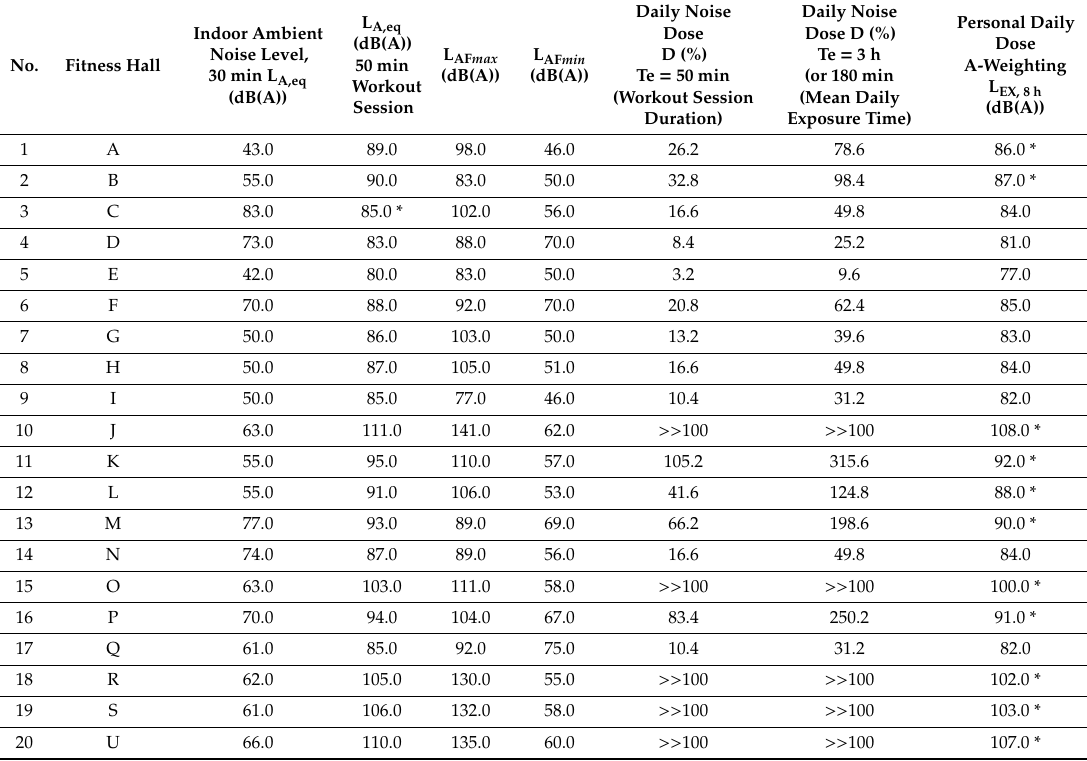
Table 3. A-weighting equivalent continuous sound pressure level for indoor ambient noise levels